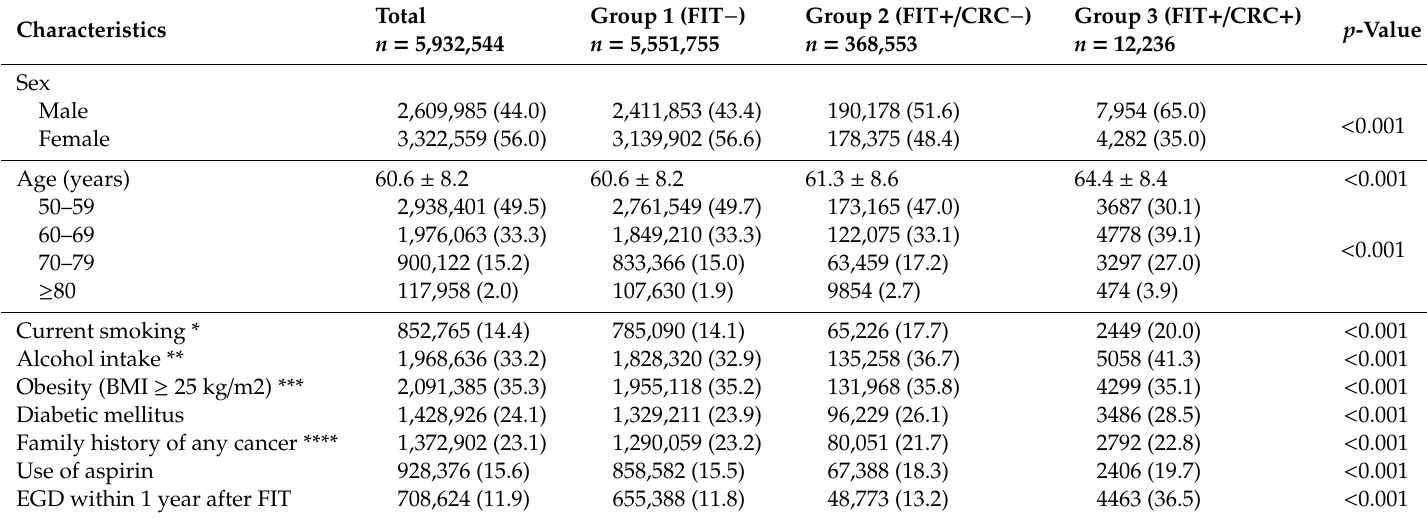
Table 1. Baseline characteristics of the study population according to FIT results and the presence of